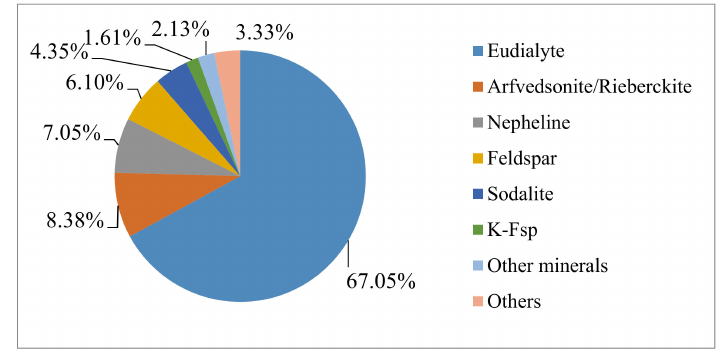
Figure 5. Mineral distribution of eudialyte concentrate (analysis by GTK,